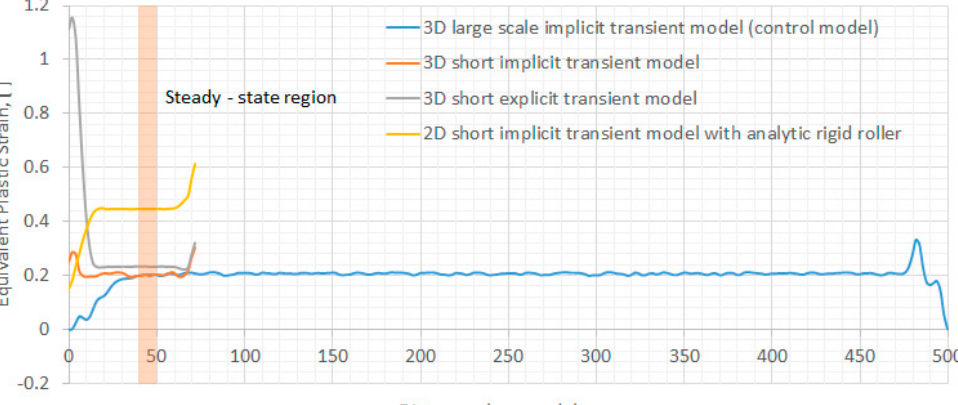
Figure 5. Equivalent plastic strain obtained along centreline on the top of the WAAM wall.